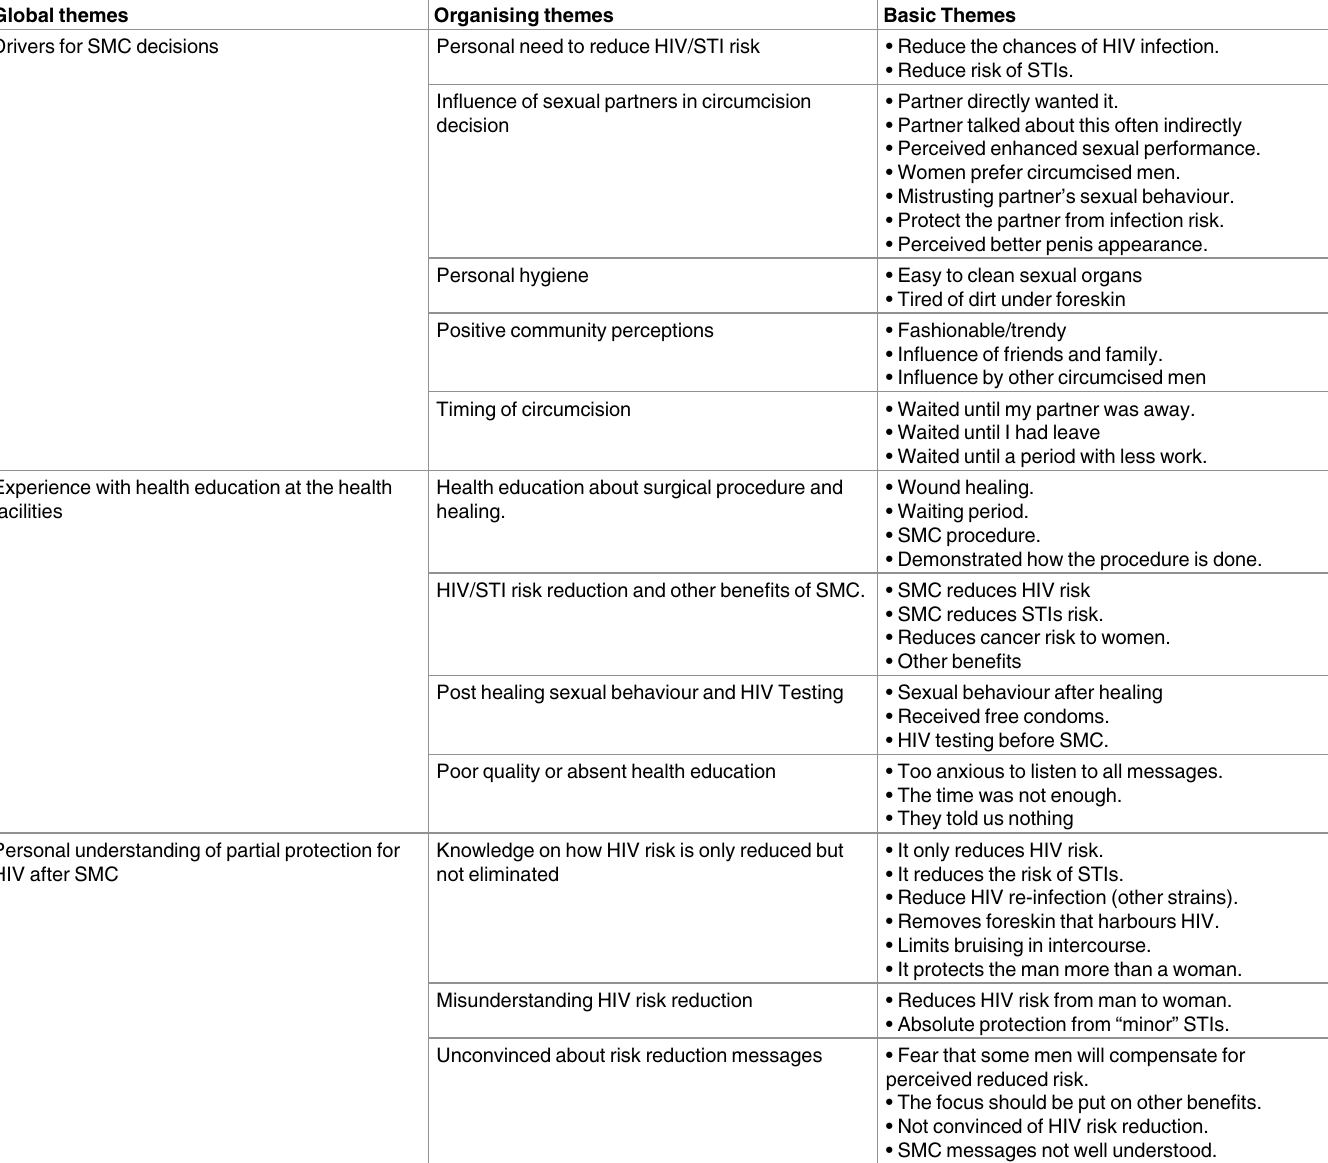
Table 2. An example of the basic, organising and global themes emerging from the